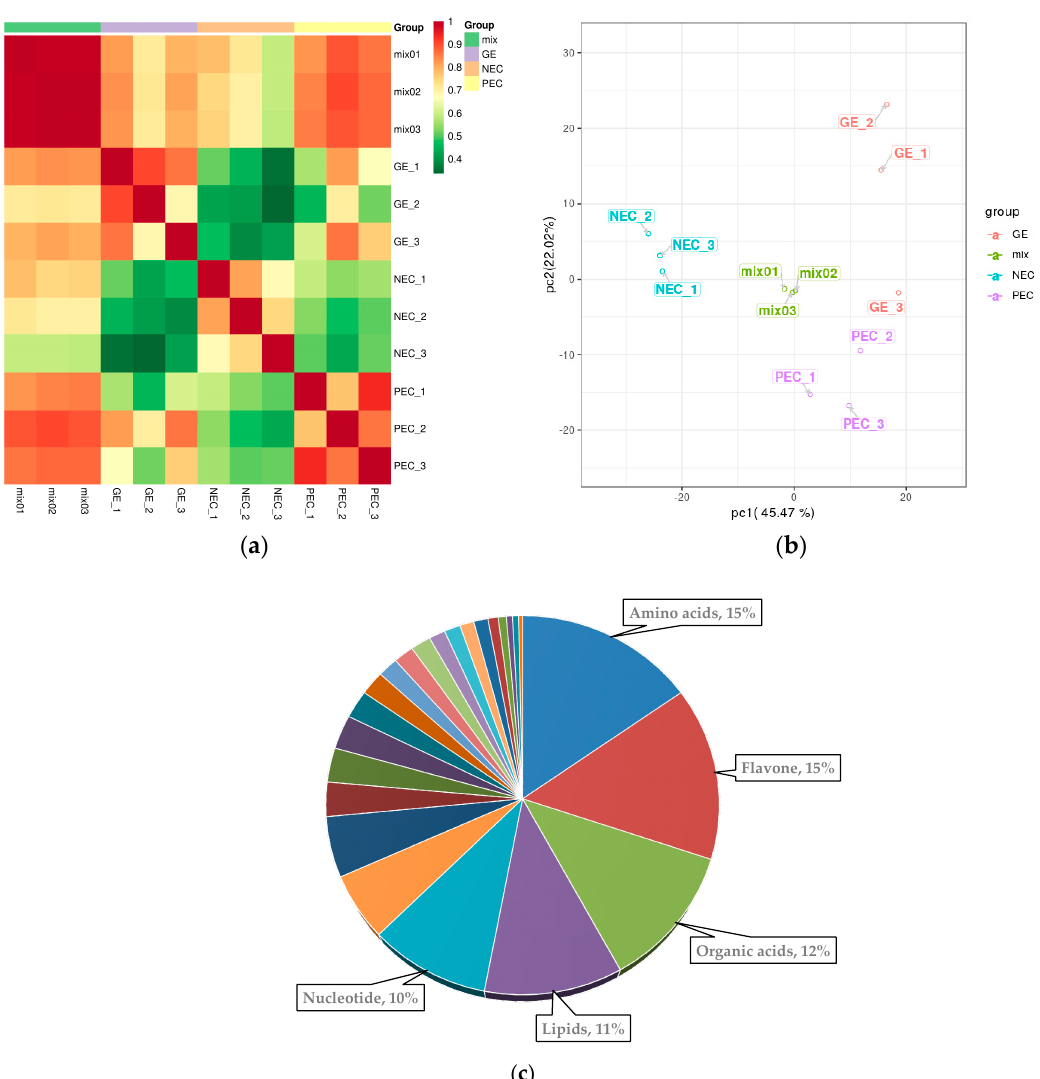
Figure 3. Overall qualitative and quantitative analysis of the metabolomics data. ( a ) Pearson’s correlation coefficients among the three samples (NEC, PEC, and GE) and quality control samples (mix); ( b ) PCA analysis of the three samples (NEC, blue; PEC, purple; GE, red) and quality control samples (mix, green); the x-axis represents the first principal component and the y-axis represents the second principal component. ( c ) Component analysis of the identified metabolites. The top five metabolites are shown beside the graph. NEC, nonembryogenic staged calli; PEC, primary embryogenic calli; GE, initiation staged embryos with globular-like enriched.